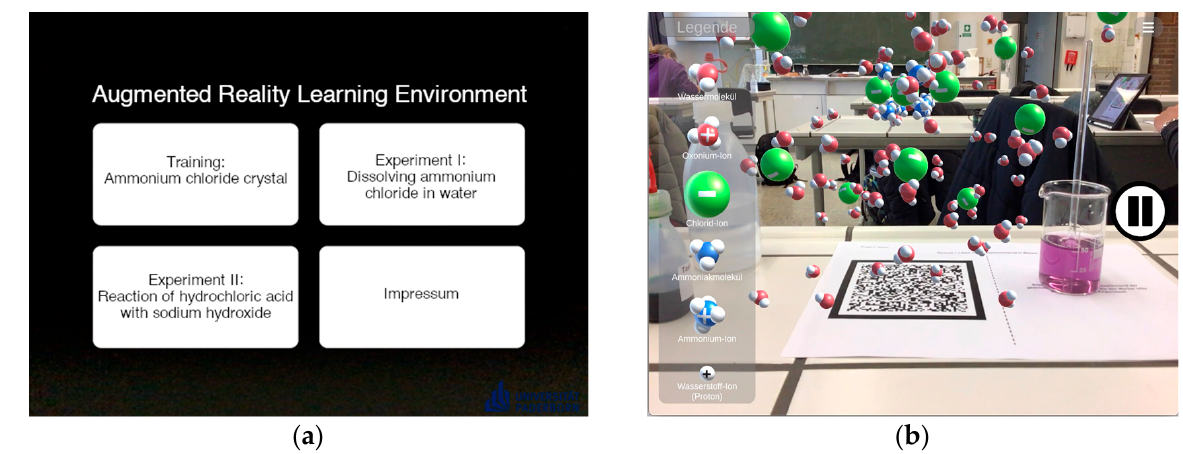
Figure 3. ( a ) Main menu of the AR app with the different environments to select (translated into English); ( b ) AR app during the experiment.